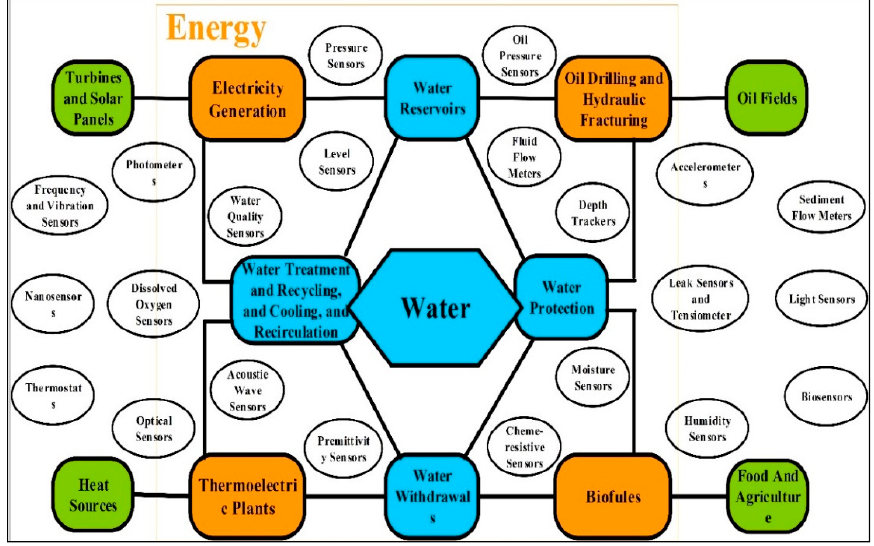
Figure 3. A network of sensor technologies for the Energy and Water Association.